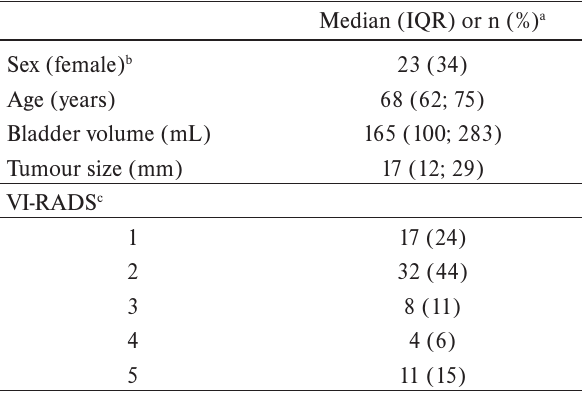
Table 1. Patients and tumours'